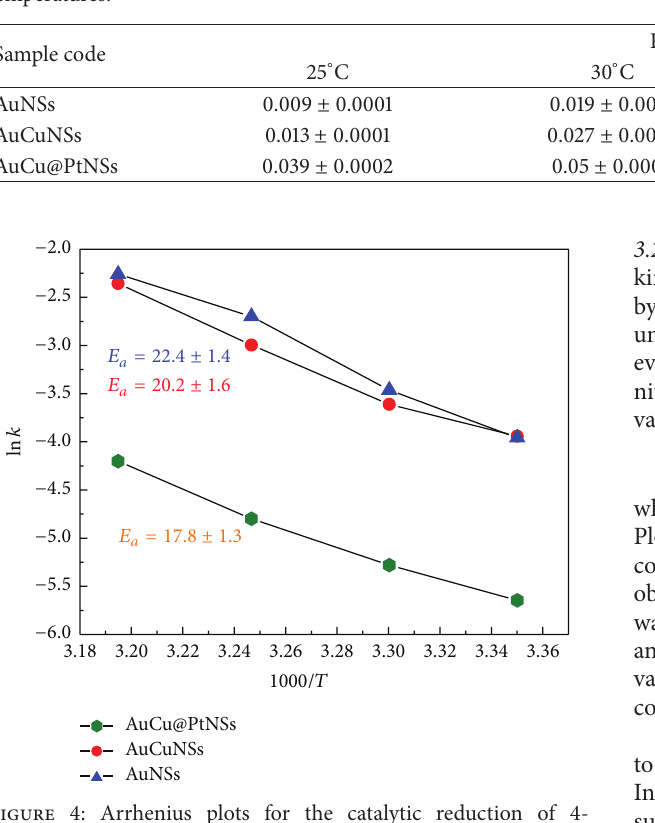
Table 2: Comparison of rate constants of 4-nitrophenol reduction process in the presence of AuNSs, AuCuNSs, and AuCu@PtNSs at different temperatures.